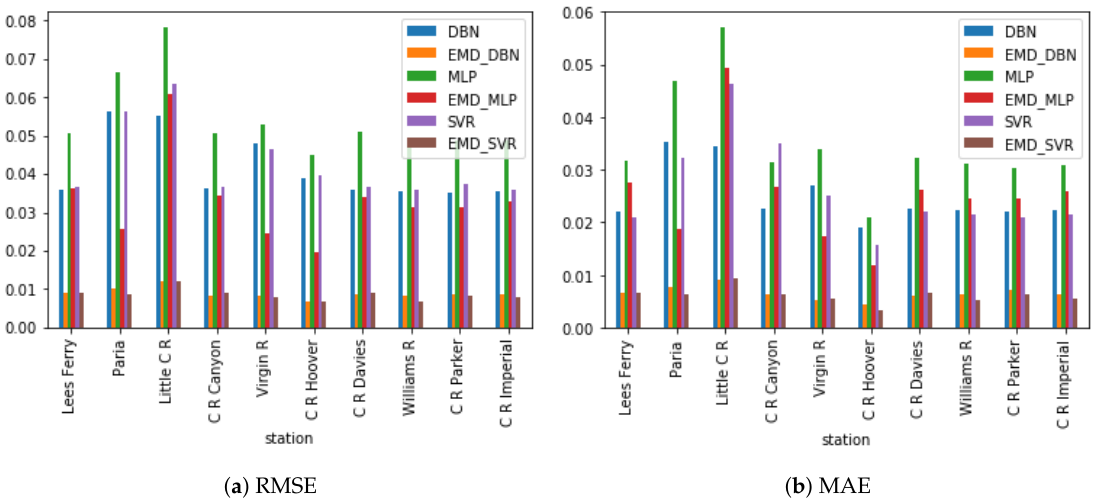
Figure 12. Comparative plots of root mean square error (RMSE) and mean absolute error (MAE) for the various methods: one step ahead. Table 2. Model results: two-step-ahead